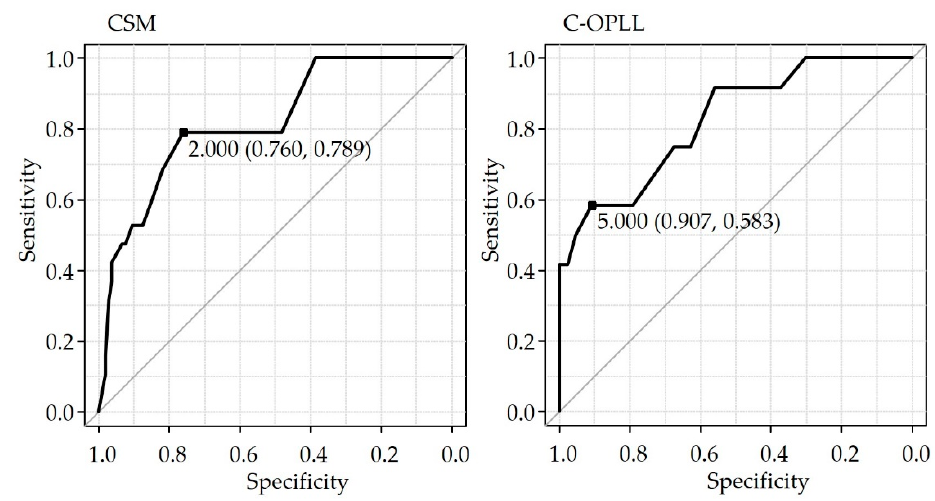
Figure 1. ROC curve. C-OPLL, Ossification of the posterior longitudinal ligament of the cervical spine; CSM, cervical spondylotic myelopathy.